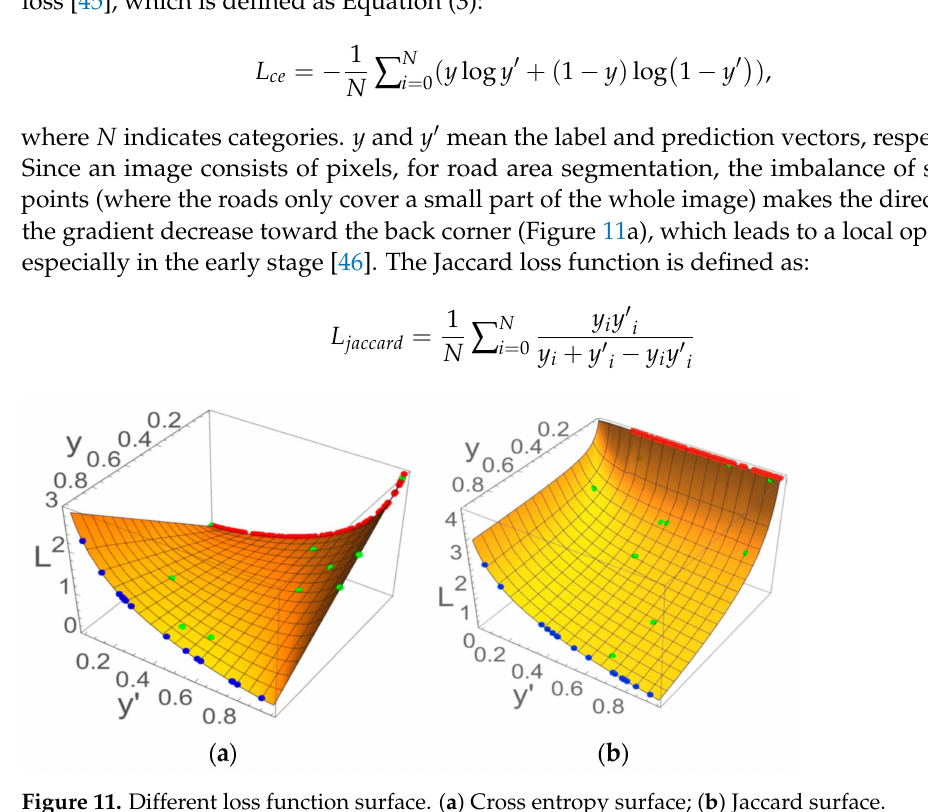
Figure 11. Different loss function surface. ( a ) Cross entropy surface; ( b ) Jaccard